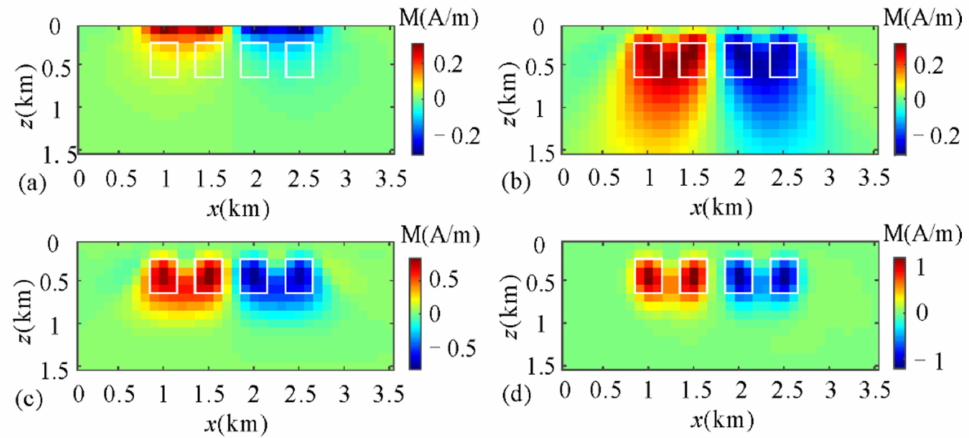
Figure 2. Vertical slices of the inversion results obtained by applying different model-weighting functions: ( a ) without depth weighting function; ( b ) with conventional depth weighting function W z (cid:48) ; ( c ) with modified depth weighting function W z ; ( d ) with the combined model-weighting function W m (The white rectangles represent the actual positions of the synthetic models. The magnetization of the two prisms on the left is 1 A/m, and the magnetization of the two prisms on the right is − 1